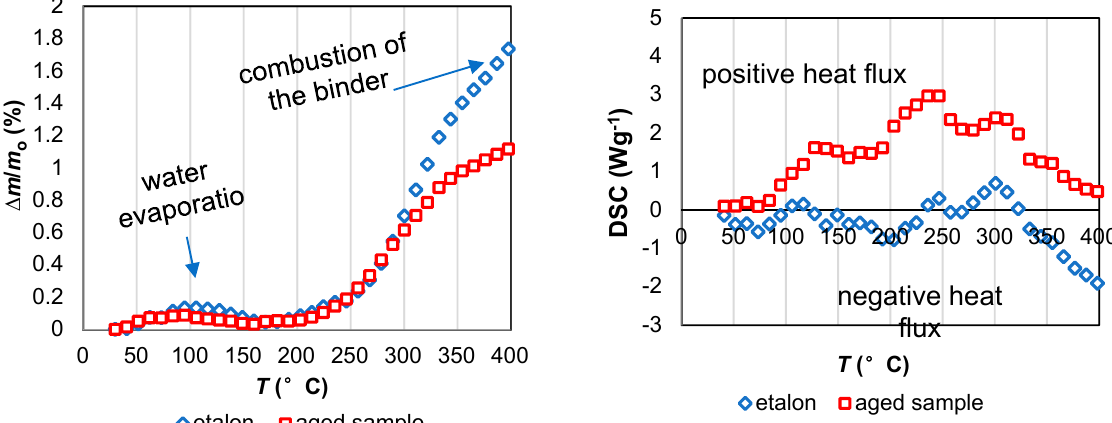
Figure 11. TGA-DSC analysis in the area below the 400 ◦ C. Normalized mass change ∆ m / m o , where ∆ m and m o are the mass change and the initial mass of the sample, respectively.